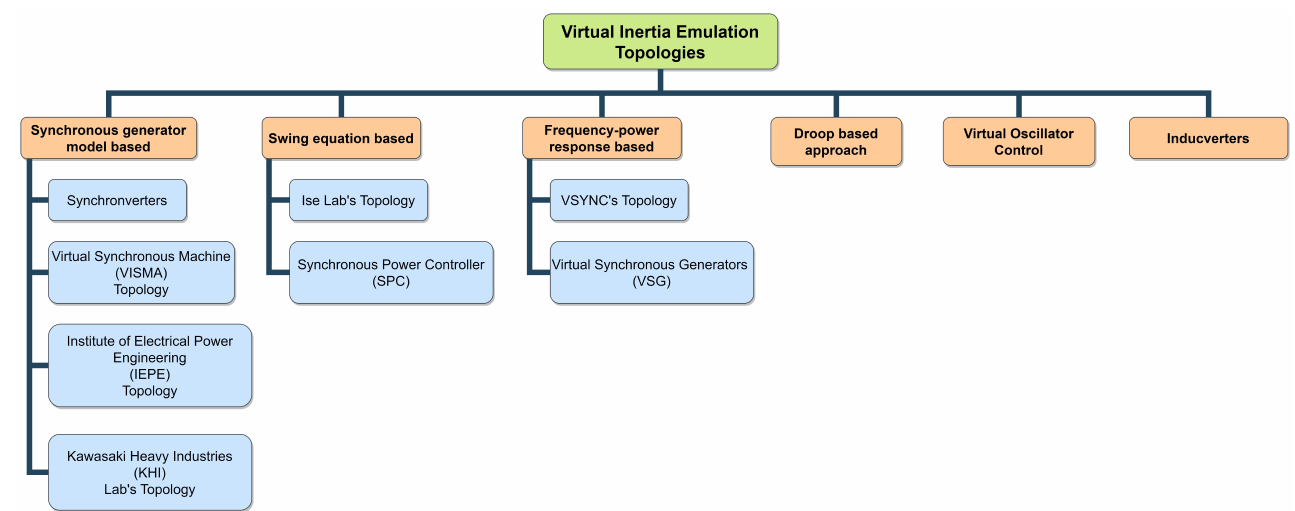
Figure 7. Virtual inertia implementation topologies [62].